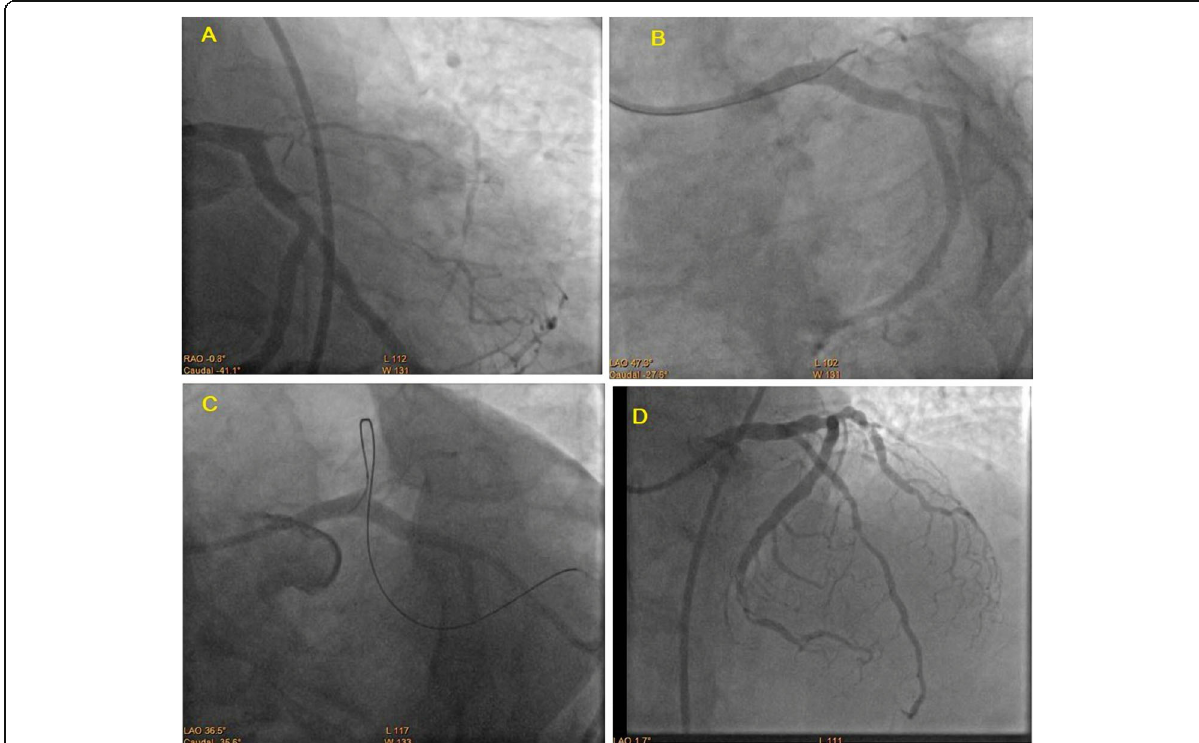
Fig. 2 a Coronary angiography of CTO of osteal LAD with J-CTO score complexity = 2. b Trial of antegrade approach c Successful retrograde approach. d Successful revascularization of total LAD by